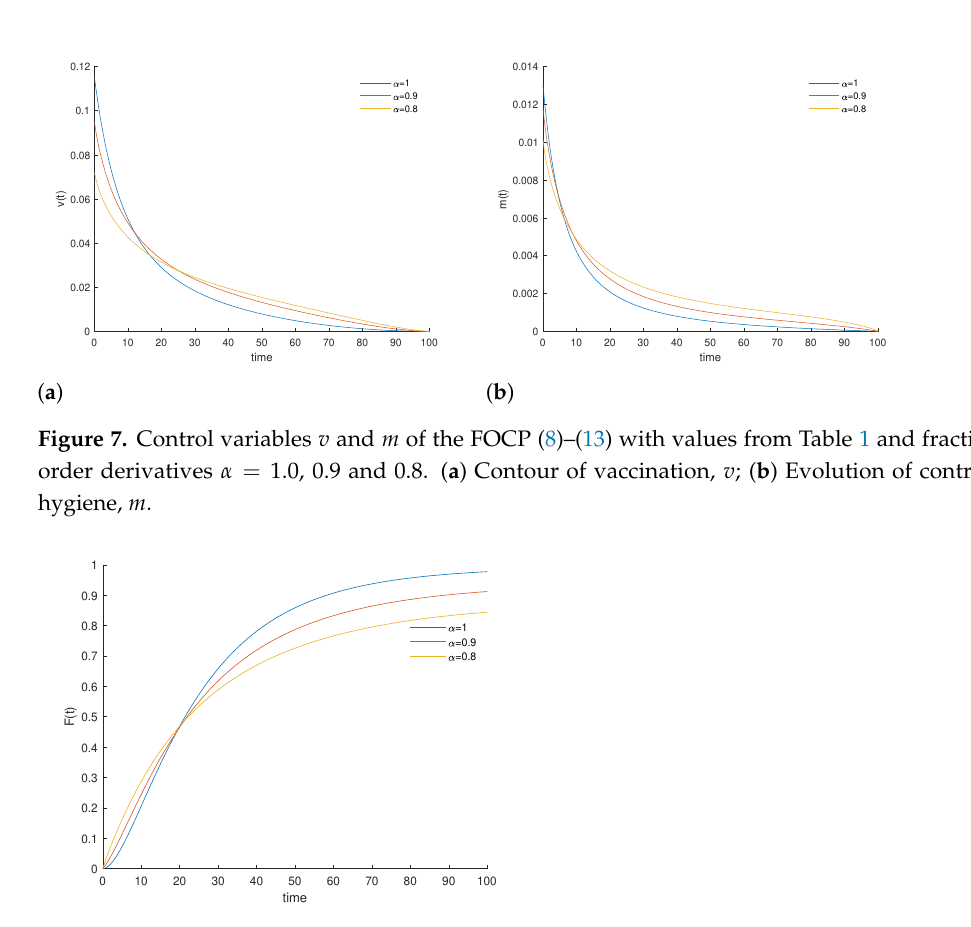
Figure 8. Evolution of the efficacy function (15) for the FOCP (8)–(13) with values from Table 1 and fractional order derivatives α = 1.0, 0.9 and